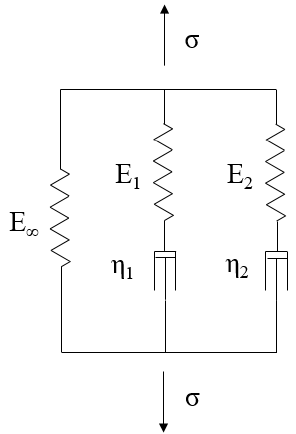
Figure 3. Generalized Maxwell Model or Wiechert Model [13].